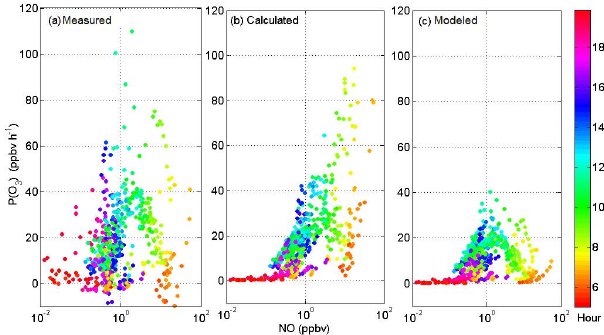
Fig. 6. P (O 3 ) in NO space (a) measured by the MOPS, (b) cal- culated and (c) modeled for overlapping points only and daylight hours. The color scale corresponds to hour of the